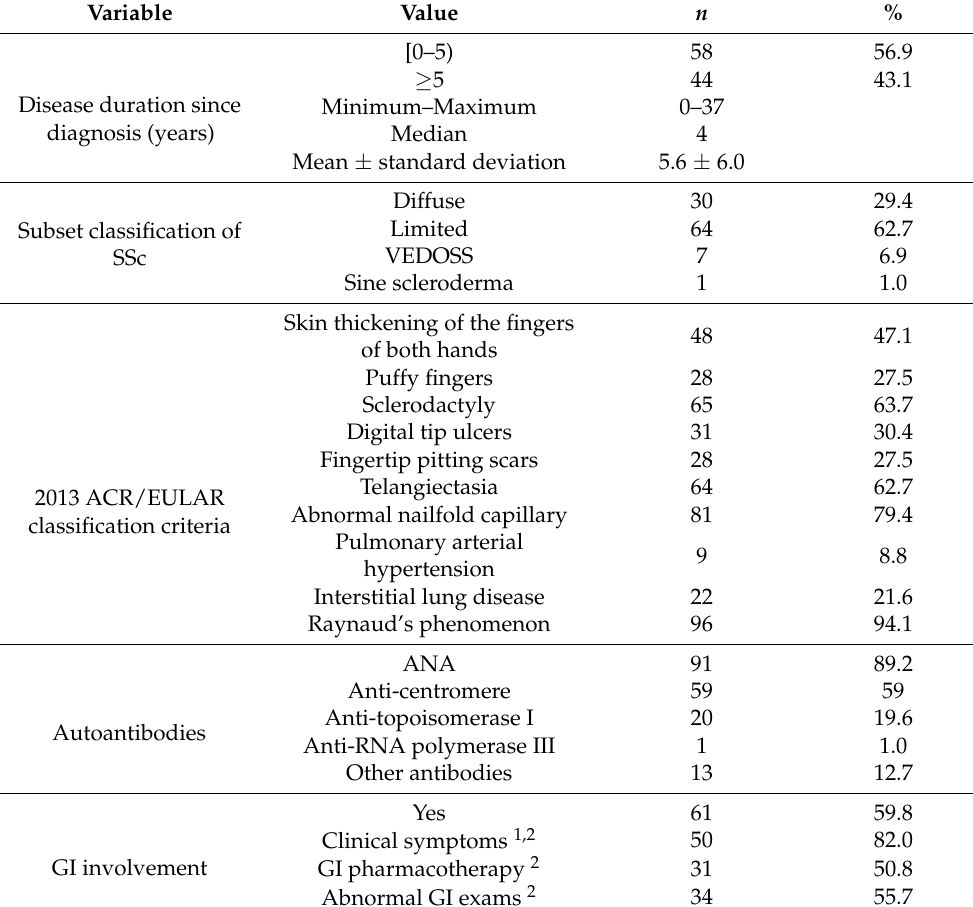
Table 2. Disease characteristics of patients ( n =